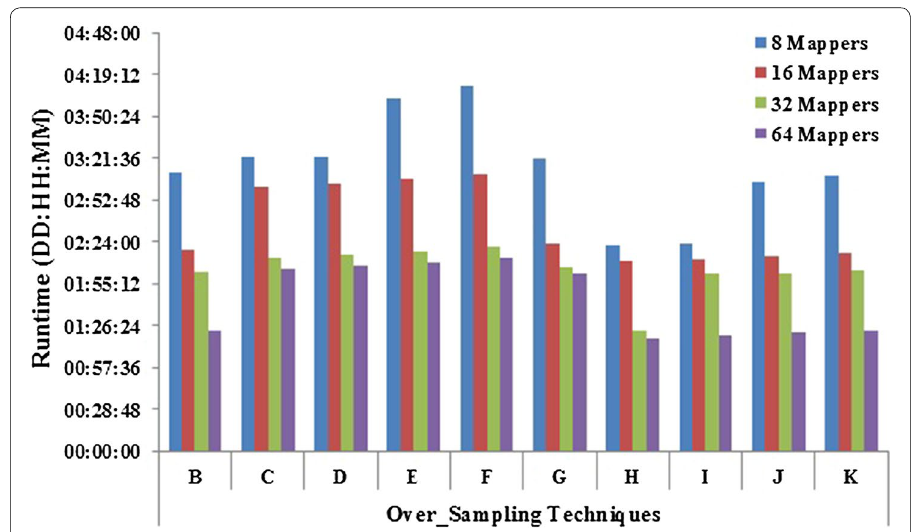
Fig. 12 Runtime (DD:HH:MM) for F-measure values of KEGG-U